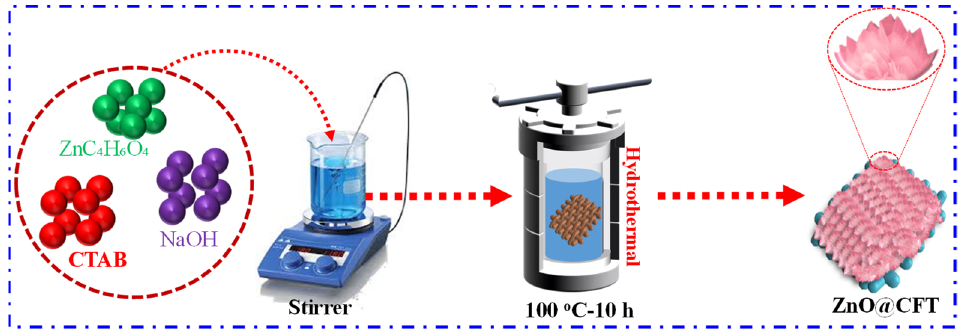
Figure 1. A schematic diagram shows the synthesis process used to develop ZnO nano-flowers di- rectly on the surface of